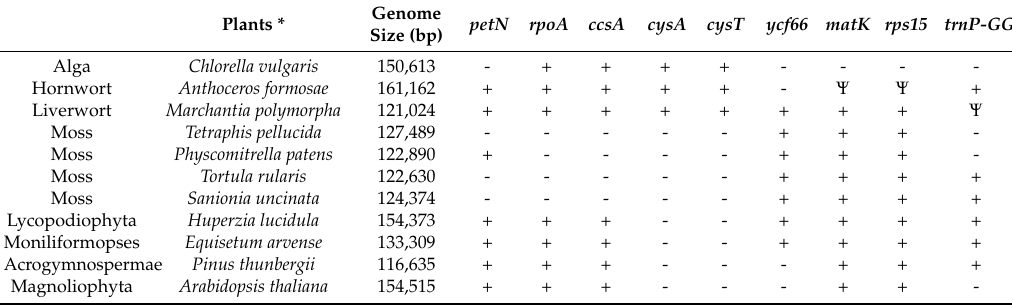
Table 4. Gene contents of plastomes from green alga, bryophytes and land